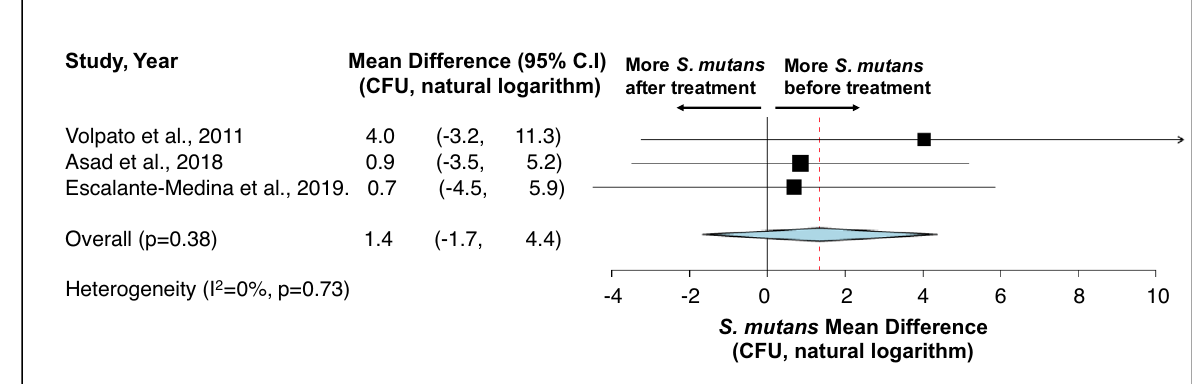
Figure 7. Effect of prenatal dental treatment on salivary S. mutans reduction. A meta-analysis was performed on two studies that assessed salivary S. mutans carriage before and after receiving prenatal dental treatment. Study heterogeneity (I 2 ) and the related p value were calculated using the continuous random effect methods. The Mean Difference, 95% CI of each study included in the meta-analysis and forest plot of comparison indicate that, regarding salivary S. mutans carriage, there is no statistically significant difference before and after prenatal dental treatment (p =